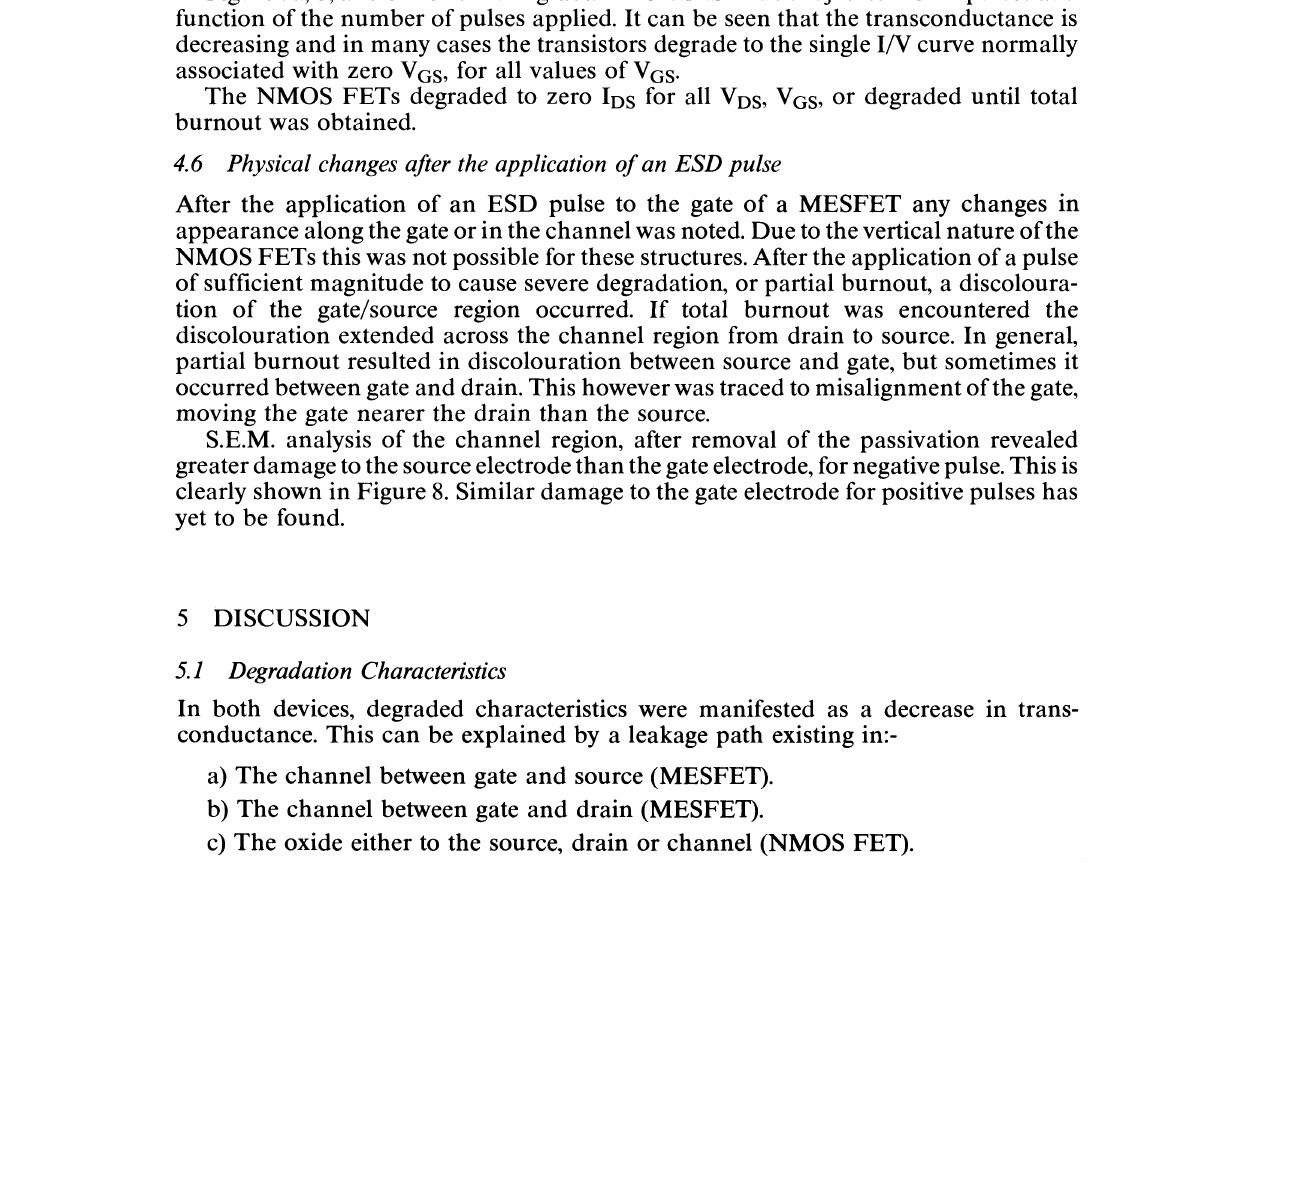
FIGURE 7 Degradation of the transconductance for a GaAs MESFET as a function ofthe number of ESD pulses applied to the gate